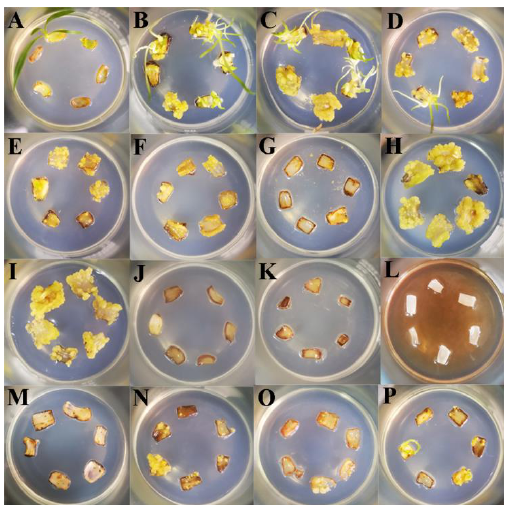
Figure 2. The e ff ects of di ff erent treatments on somatic embryo induction (50 days). Explants were inoculated in the following media for 50 days: ( A ) MS media; ( B – G ) MS media supplemented with PIC at 0.5, 1.0, 2.0, 3.0, 4.0 and 5.0 mg / L, respectively; ( H – L ) MS media supplemented with PIC at 1.0 mg / L with the pH adjusted to 4.8, 5.8, 6.8, 7.8 and 9.8, respectively; ( M ) MS media without macroelements but supplemented with PIC at 1.0 mg / L; ( N ) MS media without microelements but supplemented with PIC at 1.0 mg / L; ( O ) MS media without iron salts but supplemented with PIC at 1.0 mg / L; ( P ) MS media without organic substances but supplemented with PIC at 1.0 mg / L; All the media were adjusted to pH = 5.8 with 1 M NaOH except ( H ) and ( J – L Table 2. The results of callus induction in different media.